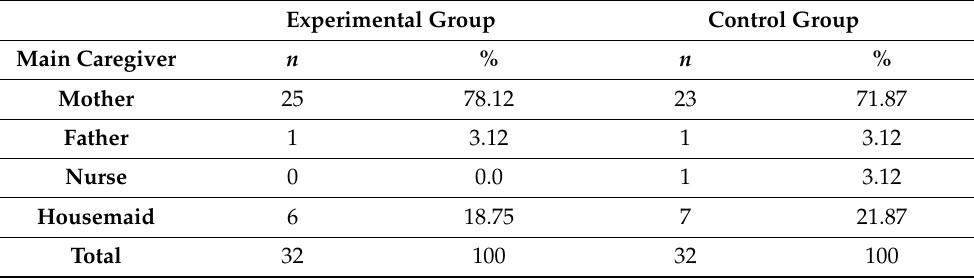
Table 2. Distribution of Caregivers Among Children with ASD. Experimental Group Control